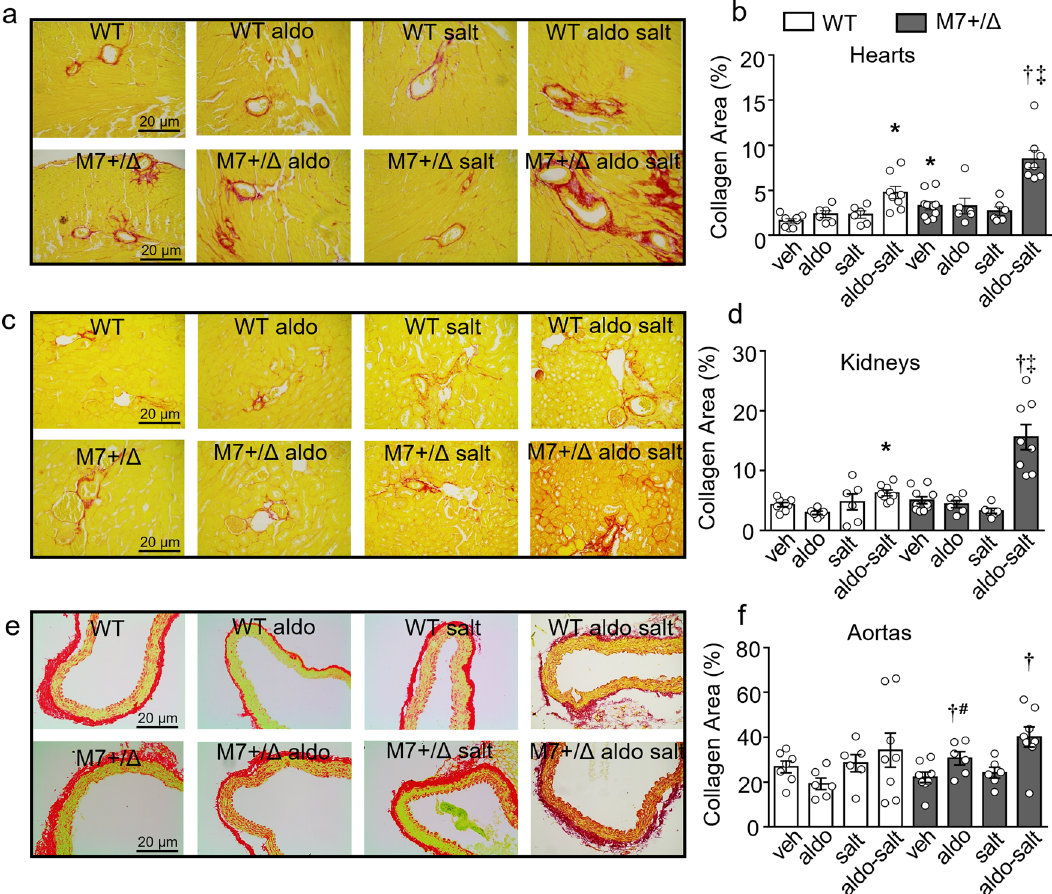
Fig. 4 Increased collagen deposition in hearts, kidneys, and aortas from WT and TRPM7 + / Δ kinase mice treated with aldosterone and salt. Tissues from WT and TRPM7 + / Δ kinase (M7 + / Δ ) mice were stained with picro-sirius red. Collagen content was assessed in bright fi eld microscopy (scale bar 20 μ m) and analyzed using the Image J software. a , b hearts, c , d kidneys, and e , f aortas. N numbers: WT (veh = 7-8, aldo = 6, salt = 6, aldo-salt = 8); M7 + / Δ (veh = 7-8, aldo = 6, salt = 6, aldo-salt = 8). Data are expressed as representative images and mean ± SEM of % of affected area. WT: white bars; M7 + / Δ : gray bars. One-way ANOVA followed by Dunnett ’ s multiple comparisons test were used for statistical analysis. * P < 0.05 vs WT veh; † p < 0.05 vs M7 + / Δ veh; ‡ p < 0.05 WT aldo-salt vs M7 + / Δ aldo-salt; # M7 + / Δ aldo vs WT